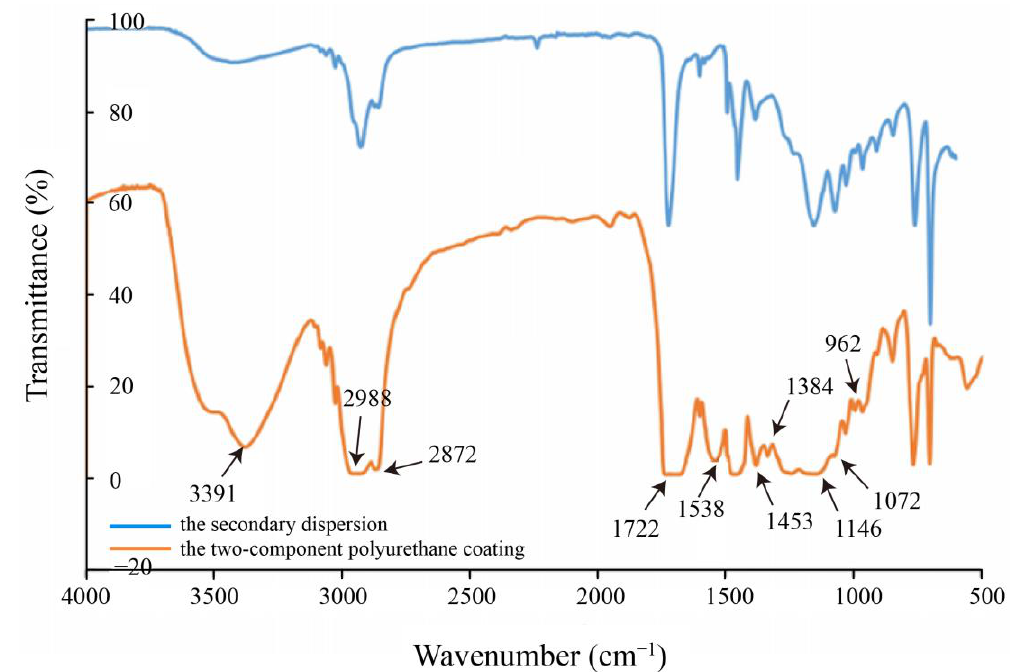
Figure 6. FTIR spectrum of the secondary dispersion (blue line) and the two-component polyurethane coating (orange line).